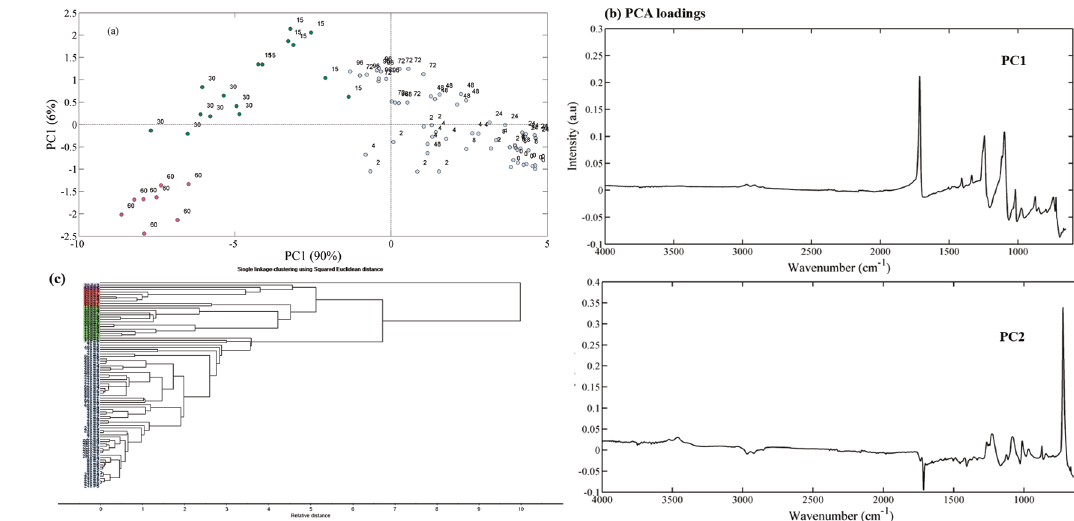
Figure 10. Exploratory analysis performed in the PET MIR spectra before and after chemical attack with NaOH at different exposure times (a) PC1 versus and PC2 score plot, (b) PC1 and PC2 loadings and (c) the dendogram of the HCA.